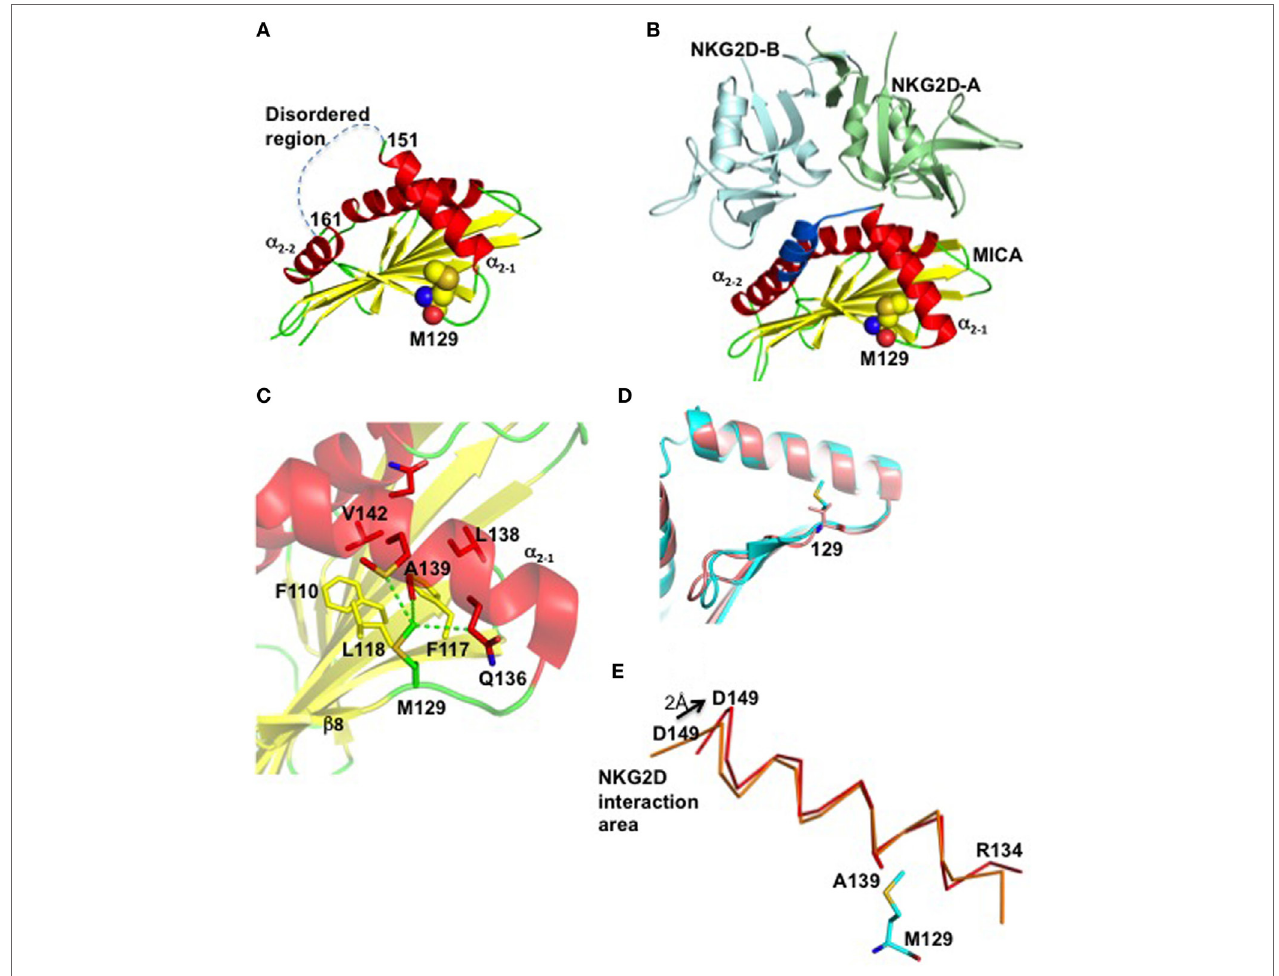
FigUre 6 | Residue Met129 is essential for appropriate positioning of the α 2–1 helix for NKG2D recognition. (a) The crystal structure of the free form of MICA is colored according to its secondary structure, with helices, β -strands and loops in red, yellow, and green, respectively. Only the α 1 and α 2 regions of MICA are displayed. The region comprising residues 152–161 and which is not visible in the electron density due to disorder, is indicated by a dashed line. All atoms forming residue Met129 are indicated as balls with oxygen, nitrogen, sulfur, and carbon atoms colored in red, blue, orange, and yellow, respectively. (B) The crystal structure of the MICA/NKG2D complex reveals that the flexible 152–161 region (in blue) is stabilized through interactions with NKG2D. The two subunits of NKG2D receptor are displayed in green and cyan. Residue Met129 is localized far away from the MICA/NKG2D interface. (c) Residue Met129 plays a key role within a hydrophobic core formed between helix α 2–1 and several β -sheet residues that surround and interact with Met129. The van der Waals interactions formed between Met129 and residues (in red) on the helix α 2–1 are indicated by green dashed lines. (D) Superposition of the α 1 α 2 domains of MICA and MICB, in pink and cyan, respectively, reveals that Met129 in MICA and Val129 in MICB take the same position and orientation, and demonstrates that MICA-129Met/Val dimorphism does not affect the conformation of the two MIC alleles (29). (e) The MICA α 2–1 helix rotates following complex formation with NKG2D. Both ends of free MICA (red) are deviating from their position in the complex with NKG2D (orange), by 1.5 and 2.0 Å at the N- and C-termini,